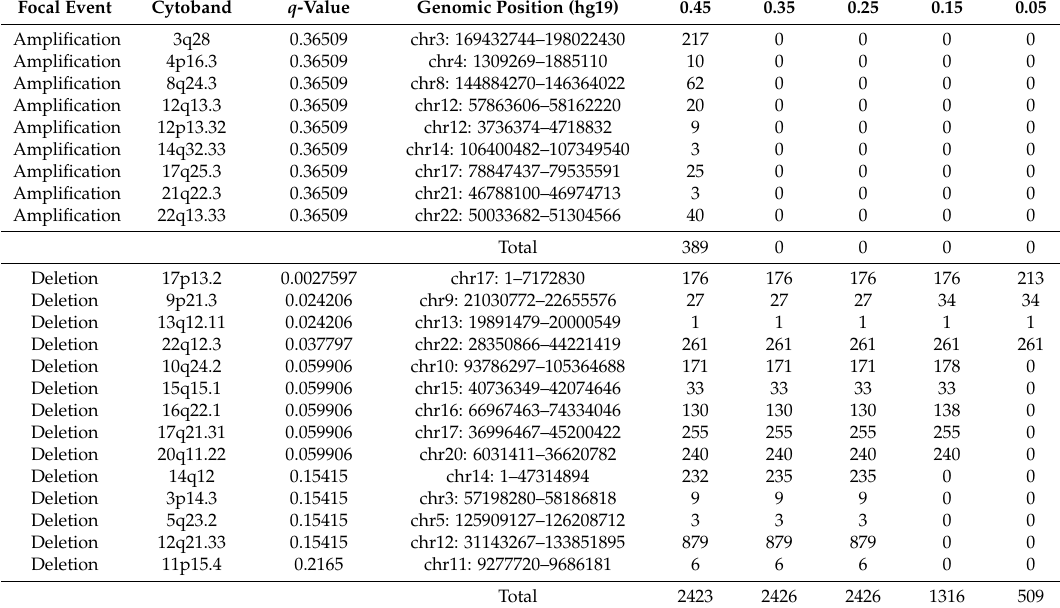
Table 5. List of regions and their associated genes located in the most common sections of recurrent DNA CNAs, derived from analysis conducted on our total astrocytic brain tumor